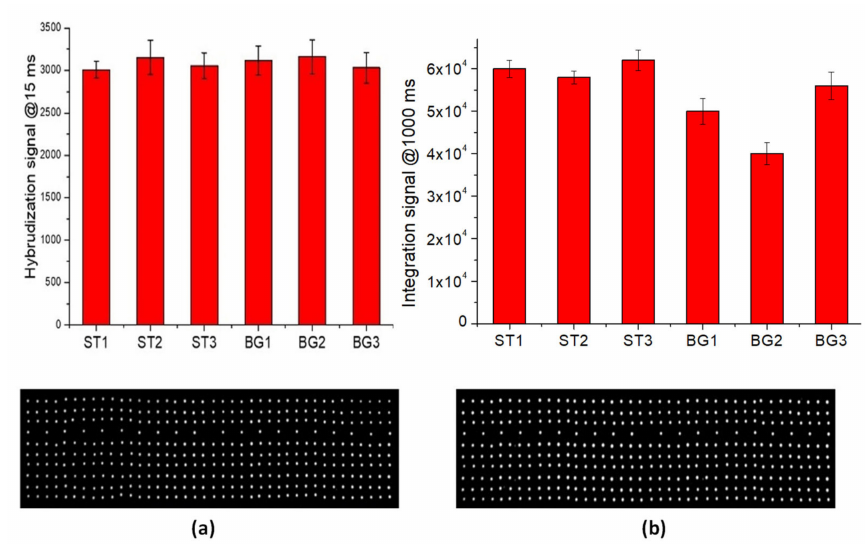
Figure 5. LoCs-MA testing: ( a ) hybridization experiment fluorescence signal (15 ms) for the hy- bridized spot ( top ) and representative fluorescence image of hybridized MA-BG ( bottom ); ( b ) In- tegrated experiment fluorescence signal (1000 ms) for the hybridized spot ( top ) and representative fluorescence image ( bottom ).